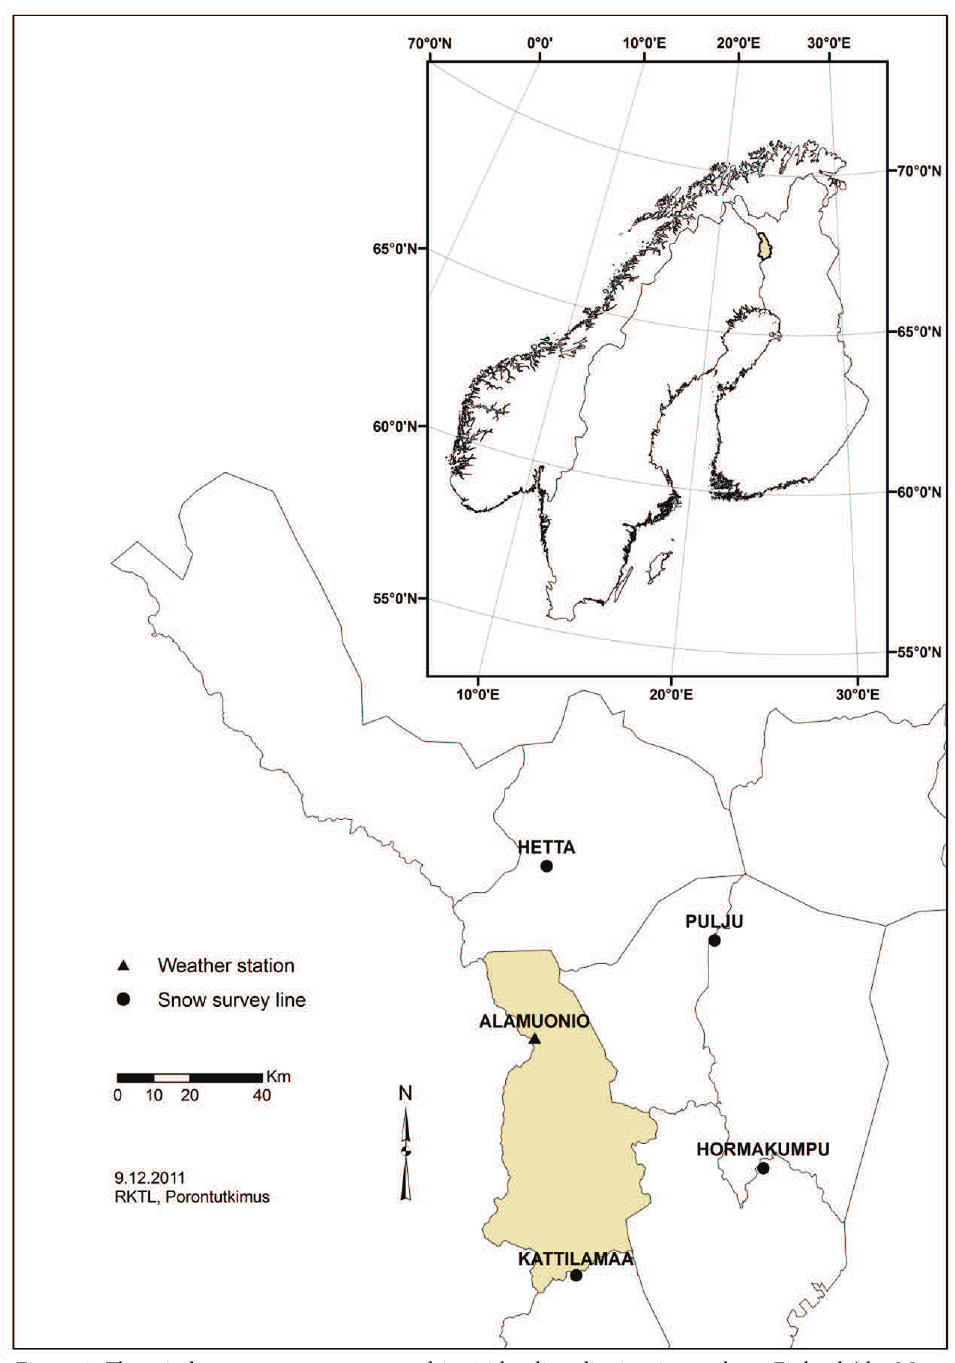
Figure 1. The reindeer management area and its 56 herding districts in northern Finland (the Muo- nio reindeer herding district shaded). Locations of the meteorological observation station operated by Finnish Meteorological Institute (FMI) in Alamuonio and the four Finnish Environment Institute’s snow measurement lines (Hetta, Hormakumpu, Kattilamaa and Pulju) are marked on the